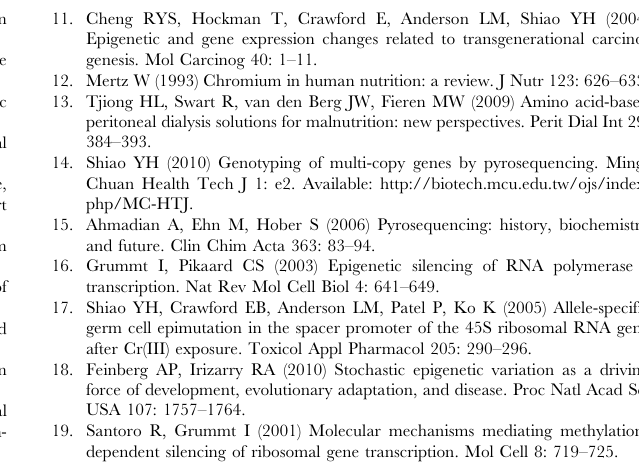
Data S3 Paired T test of tissue versus tissue and mixed- effects model of pairwise comparisons of treatments.